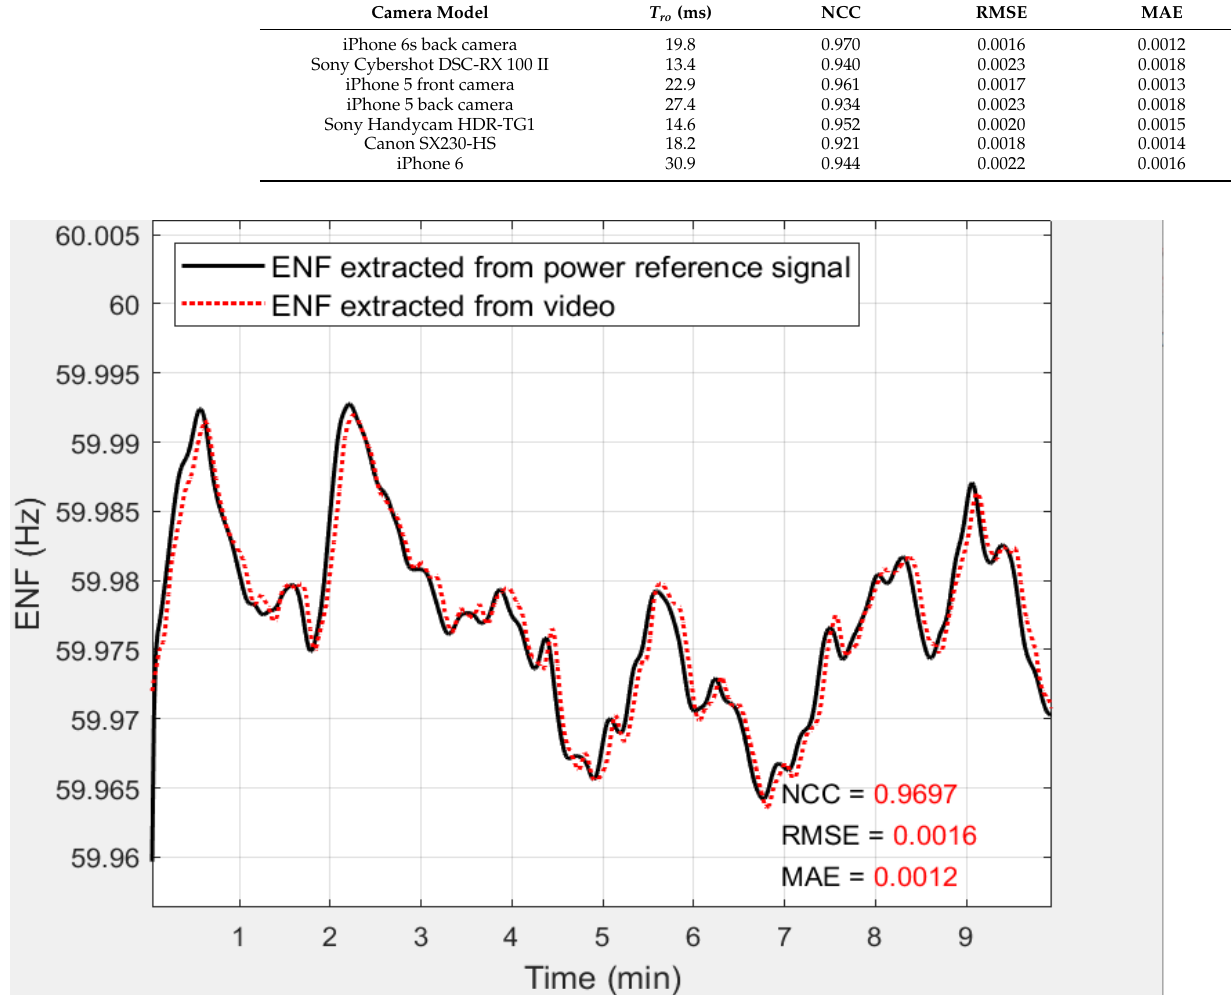
Figure 5. Sample of the ENF signal extracted from a video file (red) using a 𝑇 𝑟𝑜 value of 19.8 ms (iPhone 6s) and matched against the reference signal (black). The bottom right corner shows the measure of similarity and dissimilarity between the extracted signal and the reference signal.